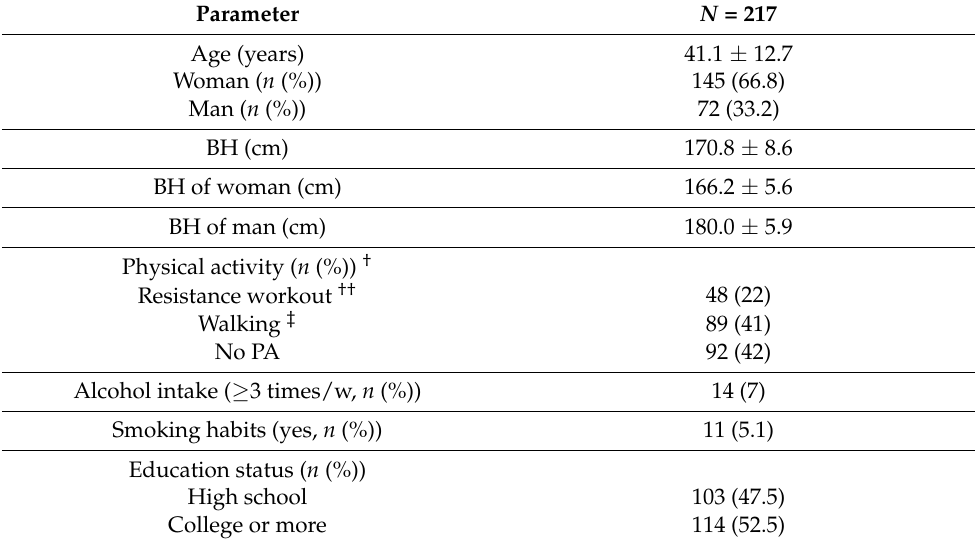
Table 1. Baseline characteristics of the participants (mean ± SD, n